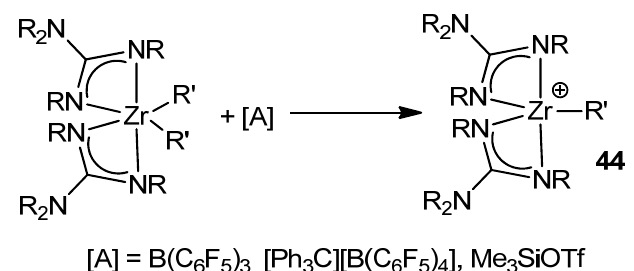
Figure 27. Cationic derivatives of a bis-guanidinato zirconium compound.